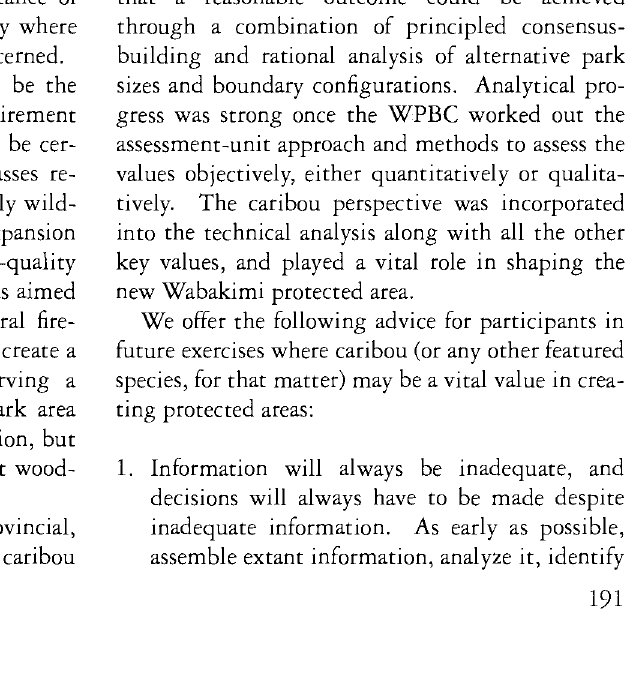
Fig. 6. Proposed boundary of a protected-area expansion at Wabakimi as announced by the Government of Ontario in April